Question: Sum up the contents of this chart in one sentence.
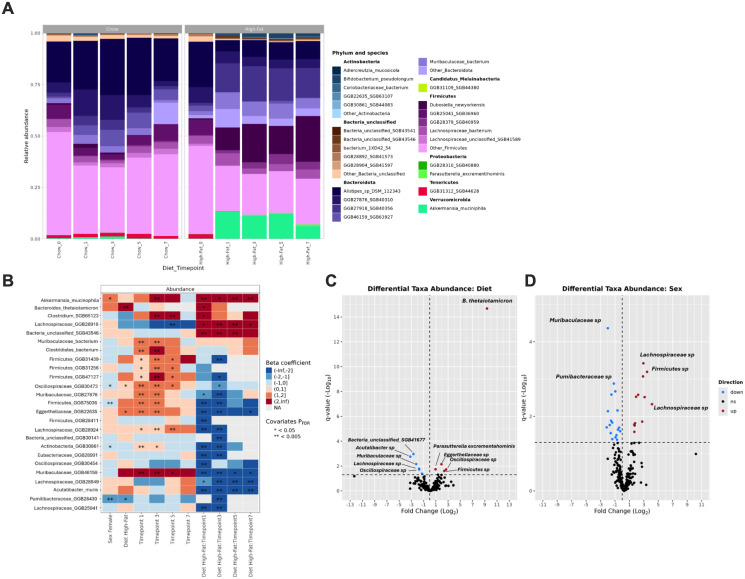
Answer: Microbial species that differ significantly in abundance between diet groups and sexes. (A) Relative abundance bar plots of bacterial taxa present at the species level in CH and HF diets at pre-diet shift, pre-CLL engraftment, 4-weeks post-engraftment, 8-weeks post-engraftment, and 12-weeks post-engraftment. The five most abundant species within each phylum are displayed, with remaining species aggregated into an “Other” category. (B) Heatmap depicting differential taxa abundance at the genus-species level. Labels along the x-axis correspond to regression coefficients (i.e., independent variables) in a fitted MaAsLin 3 model, with colors denoting the sign and magnitude of those coefficients. * FDR-adjusted p < 0.05, ** FDR-adjusted p < 0.005. (C) Volcano plot depicting downregulated (blue dots) and upregulated (red dots) taxa based on diet (i.e., CH vs. HF). (D) Volcano plot depicting downregulated (blue dots) and upregulated (red dots) taxa based on sex (i.e., male vs. female). CH, chow; HF, high-fat; pre-diet shift = Chow/High-Fat_0; pre-CLL engraftment = Chow/High-Fat_1; 4-weeks post-engraftment = Chow/High-Fat_3; 8-weeks post-engraftment = Chow/High-Fat_5; 12-weeks post-engraftment = Chow/High-Fat_7. Volcano plot p -values and fold changes were outputted by MaAsLin 3.